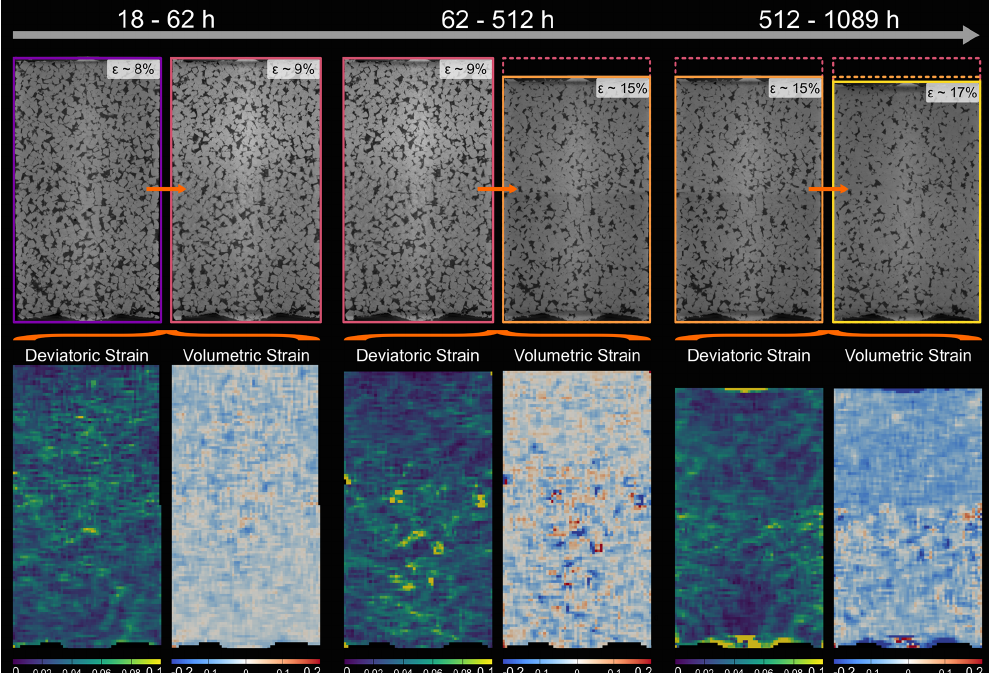
Figure 11. Locally resolved strain in the pure NaCl sample. The absolute values of deviatoric and volumetric strain were calculated from digital volume correlation for three different time steps. The top row shows the two microtomography scans which were compared to each other using digital volume correlation. Further, the contours are showing the sample dimensions, ranging in colour from purple for the least compacted sample to yellow for the most compacted sample. In the bottom row, the results of the strain calculation are displayed. Note that the strains are added up and cover the entire time interval between the two selected scans. The time intervals increase from the left to the right and are 44, 450 and 577h. For the deviatoric strain, bright colours represent high strains, whereas dark colours represent low strains. For the volumetric strain, blue indicates compaction, while red indicates